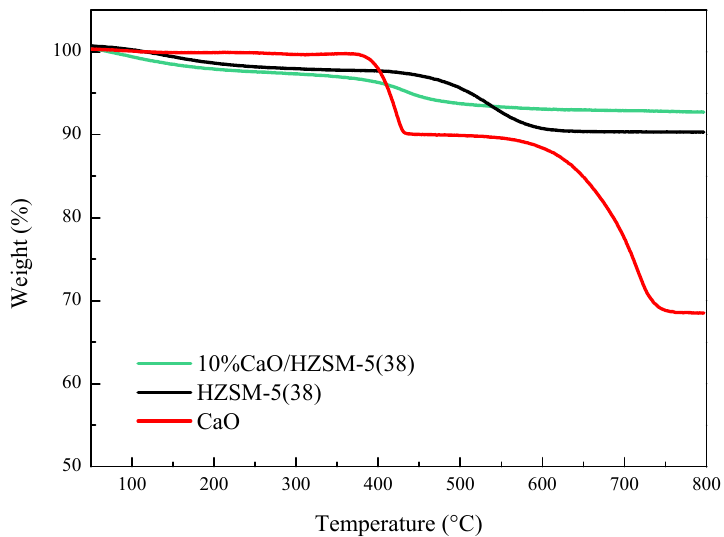
Figure 5. TGA profiles for the spent catalyst samples of 10%CaO/HZSM-5(38) and HZSM-5(38). (TOS = 2 h). (TOS = 2 h).